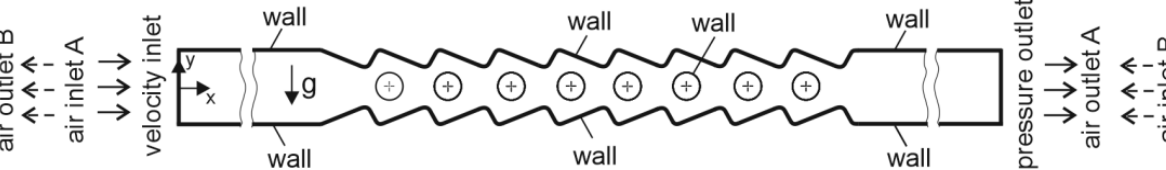
Figure 3. Boundary conditions for forward and backward air flow in the wavy channel.